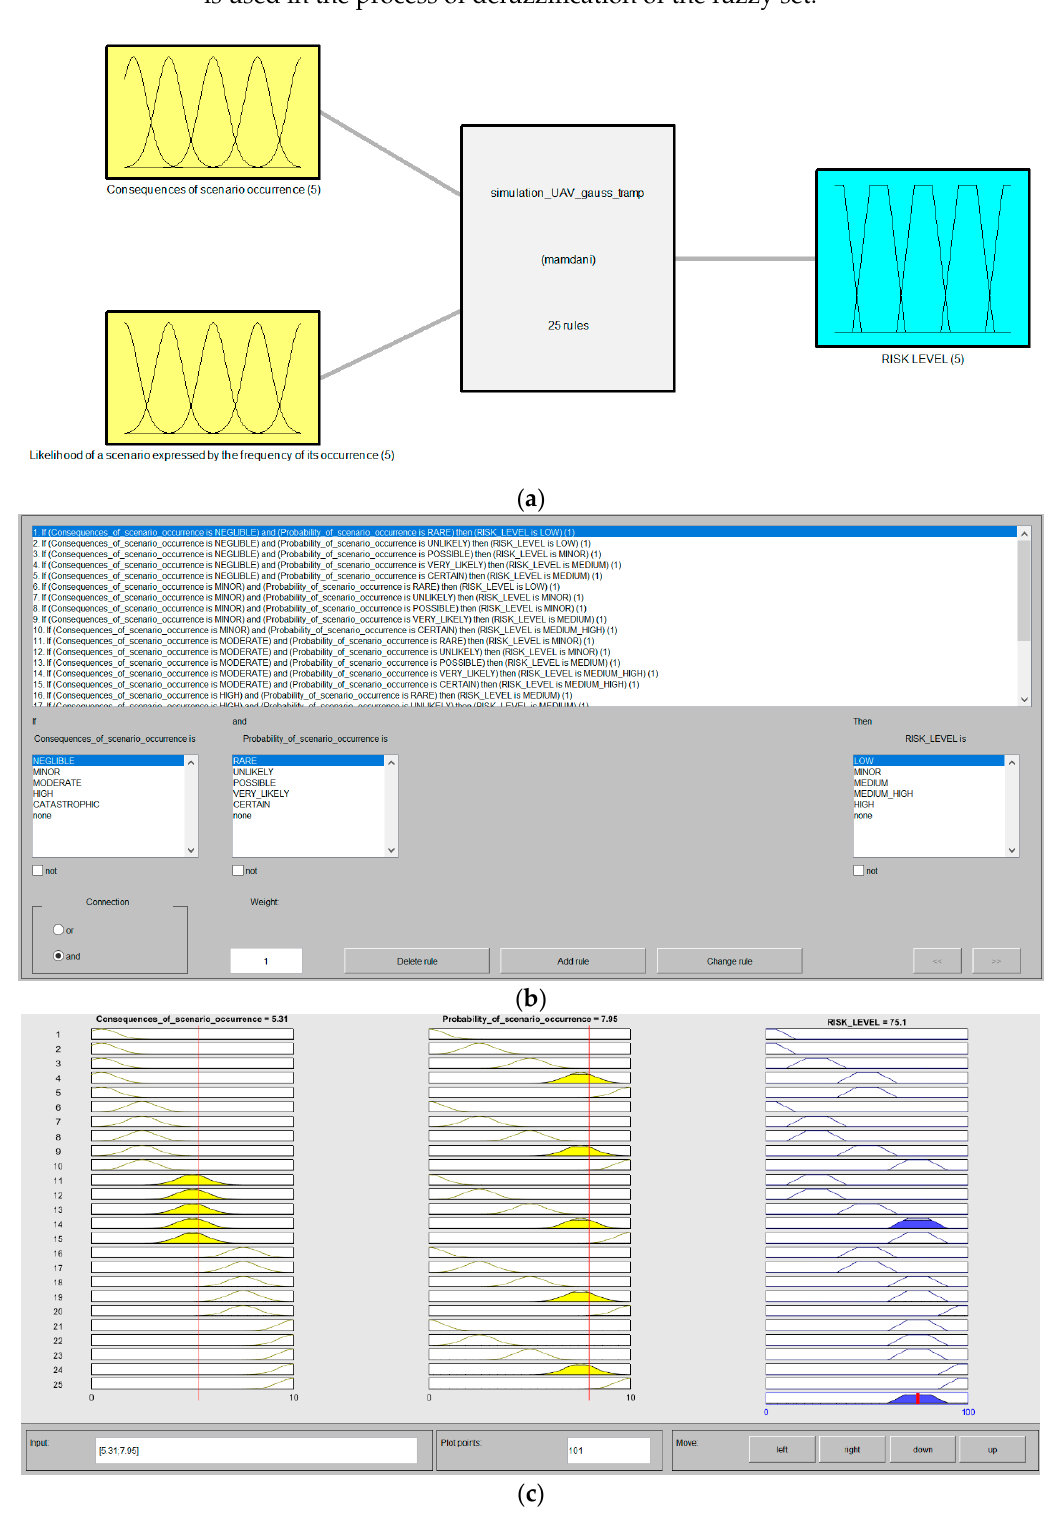
Figure 7. Mamdani model in MATLAB: ( a ) General view; ( b ) FIS engine with processing rules; ( c ) Rules viewer.